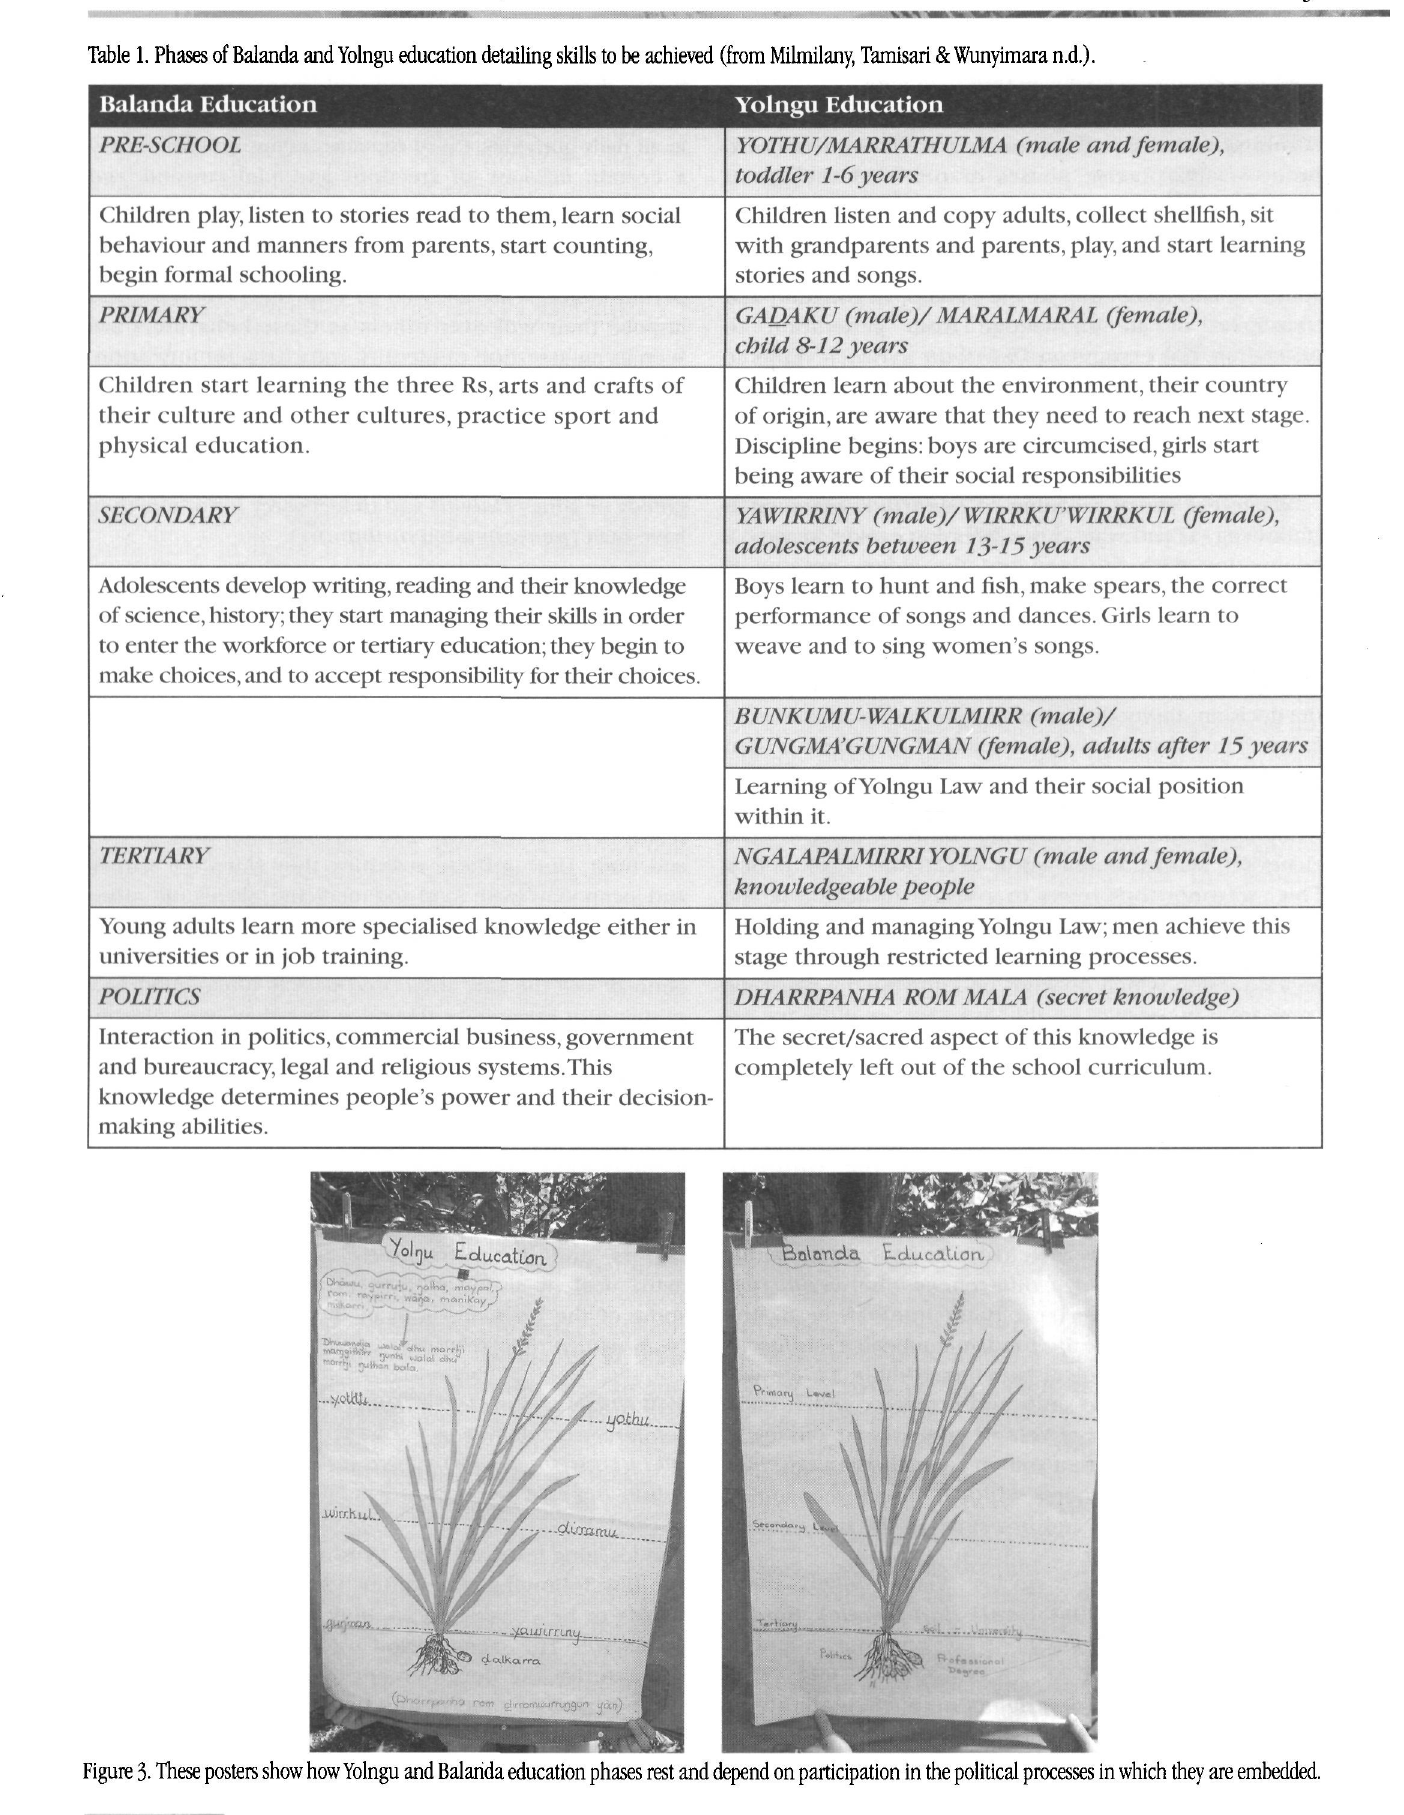
Figure 3. These posters show how Yolngu and Balanda education phases rest and depend on participation in the political processes in which they are